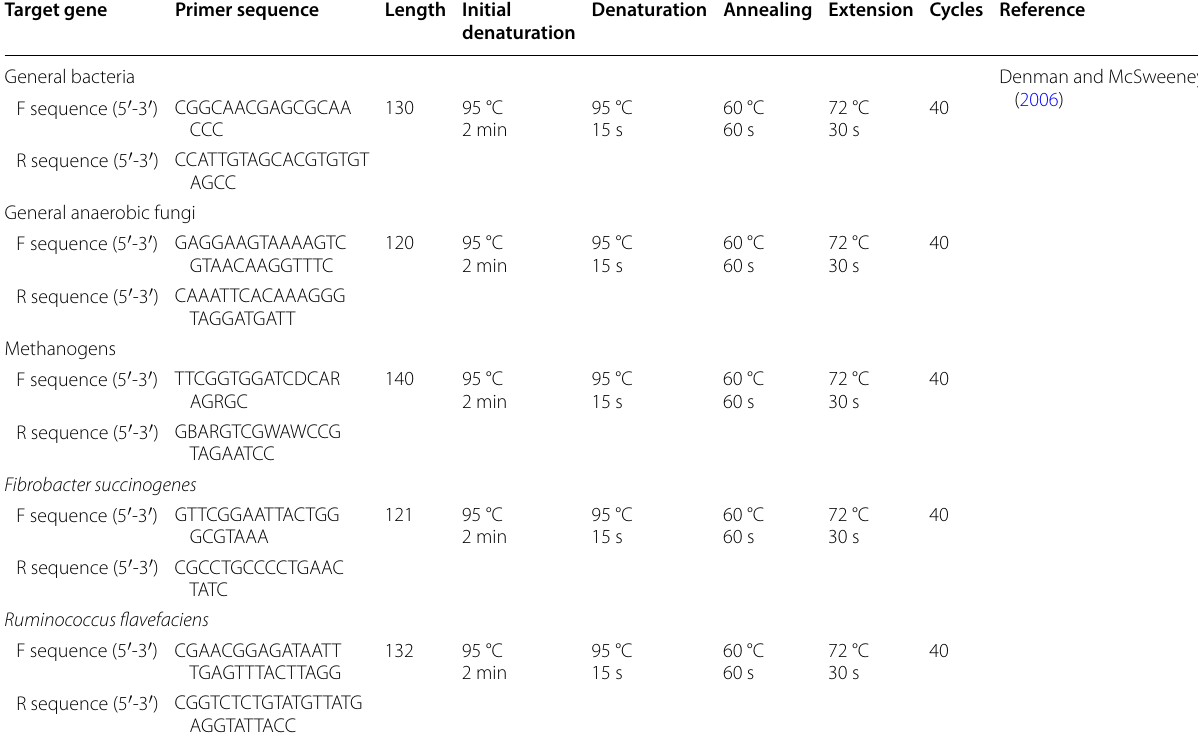
Table 1 Real time PCR primers used for the quantification of microbial population Target gene Primer sequence General bacteria